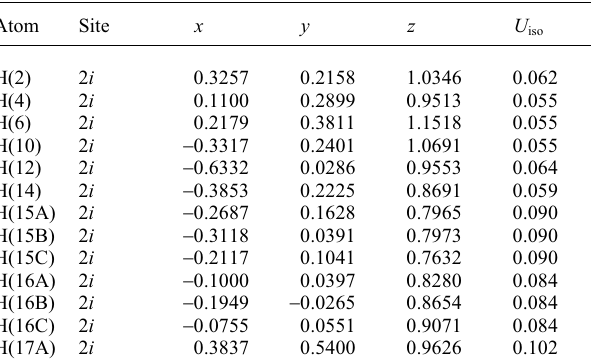
Table 2. Atomic coordinates and displacement parameters (in Å 2 ) .